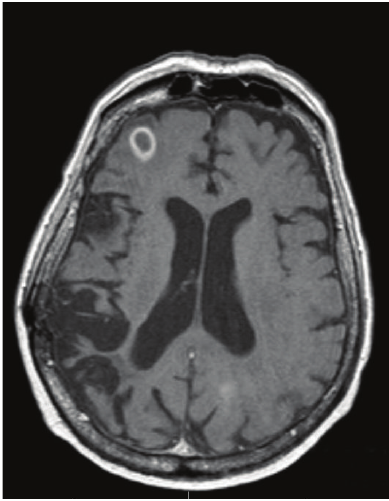
Figure 2: Magnetic resonance imaging of the brain showing ring enhancing lesion in the right frontal lobe, on initial presentation.